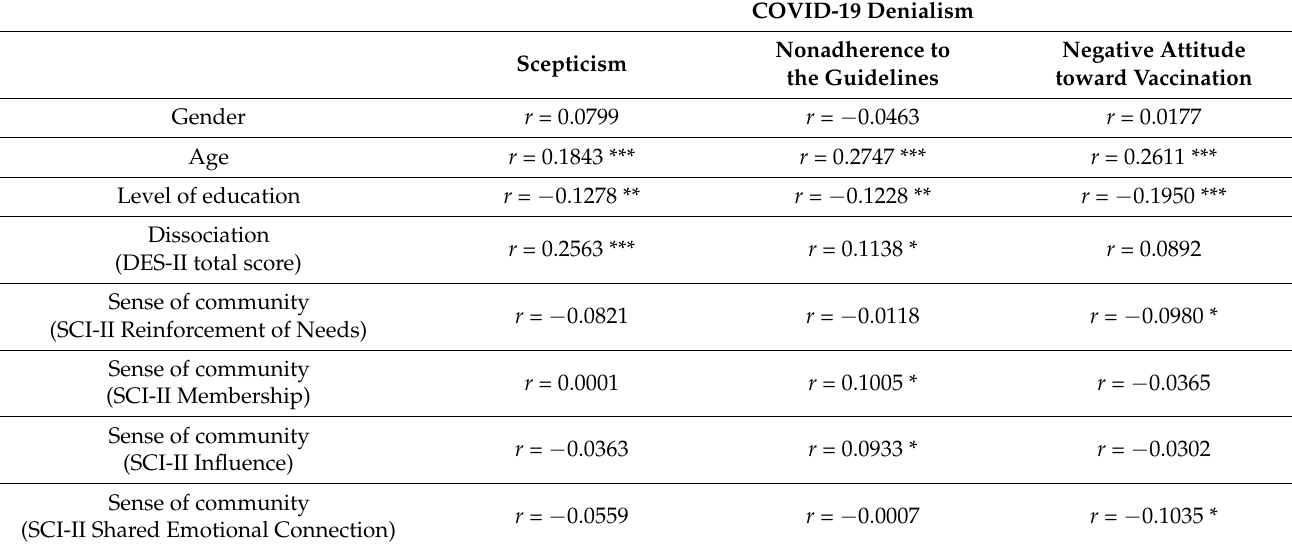
Table 1. Correlations (Pearson’s r ) computed between the sociodemographic variables (gender, age, and level of education), dissociation (Dissociative Experiences Scale II (DES-II) total score), sense of community (sense of community index II (SCI-II) subscales: Reinforcement of Needs, Membership, Influence, and Shared Emotional Connection), and COVID-19 denialism (scepticism, nonadherence to the guidelines, and negative attitude toward vaccination) ( n = 461). COVID-19 Denialism Nonadherence to Negative Attitude Scepticism the Guidelines toward Vaccination